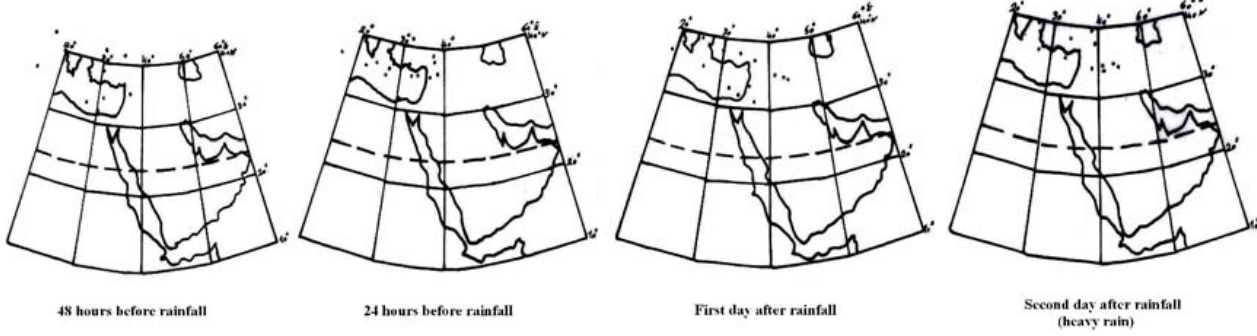
Fig. 19. The location of the 700hPa LA centers of the 20 selected floods two days before the rainfall (left pictures) and in first day and second day of heavy rainfalls (right pictures)